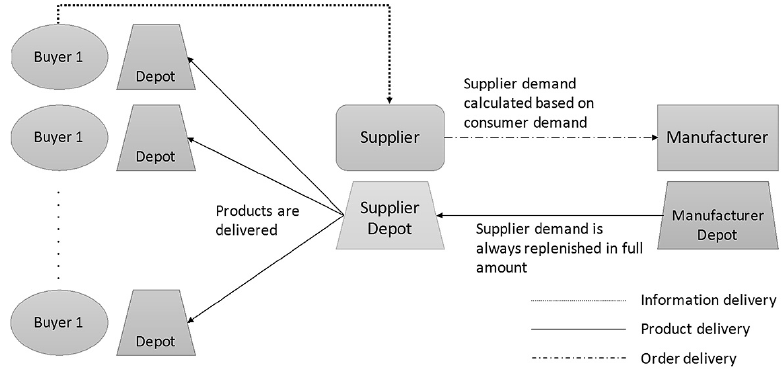
Fig. 3. Resemblance of the VMI